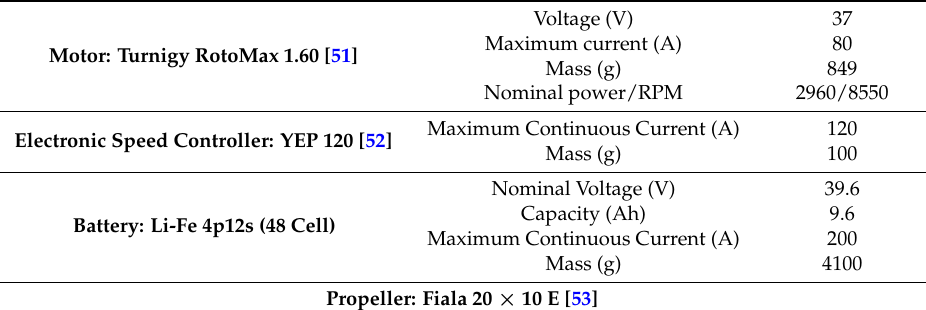
Table 1. Electric propulsion system applied in the joined wing